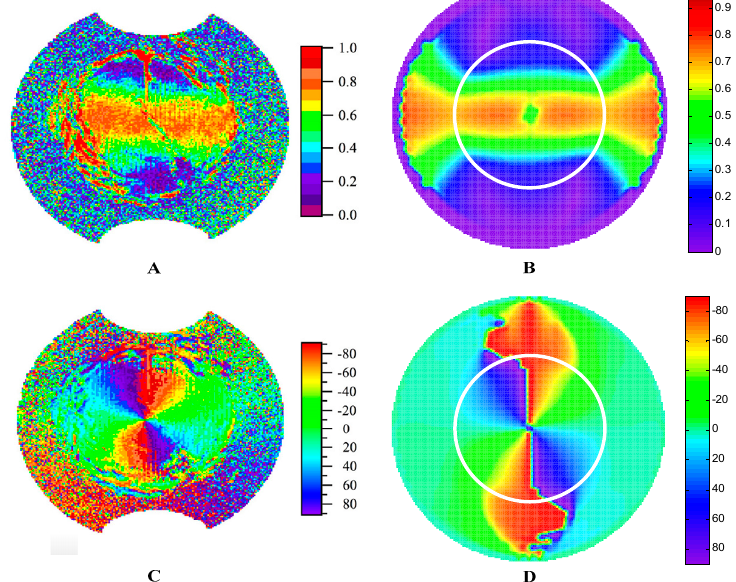
Figure 16 . DOP ( A ); and AOP ( B ) graphs measured by Bhandari [24]. Simulated: DOP ( C ); and AOP ( D ) graphs.